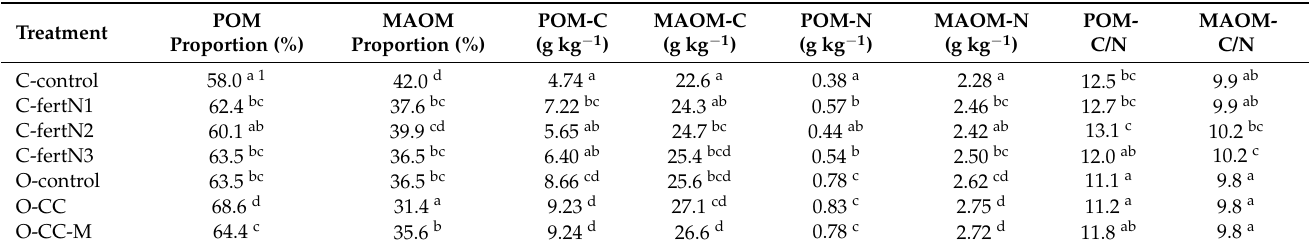
Table 6. Soil particulate organic matter (POM) and mineral-associated organic matter (MAOM) proportions, organic carbon fractions (POM-C and MAOM-C), total nitrogen concentrations (POM-N and MAON-N), and C/N ratios depending on the treatments.